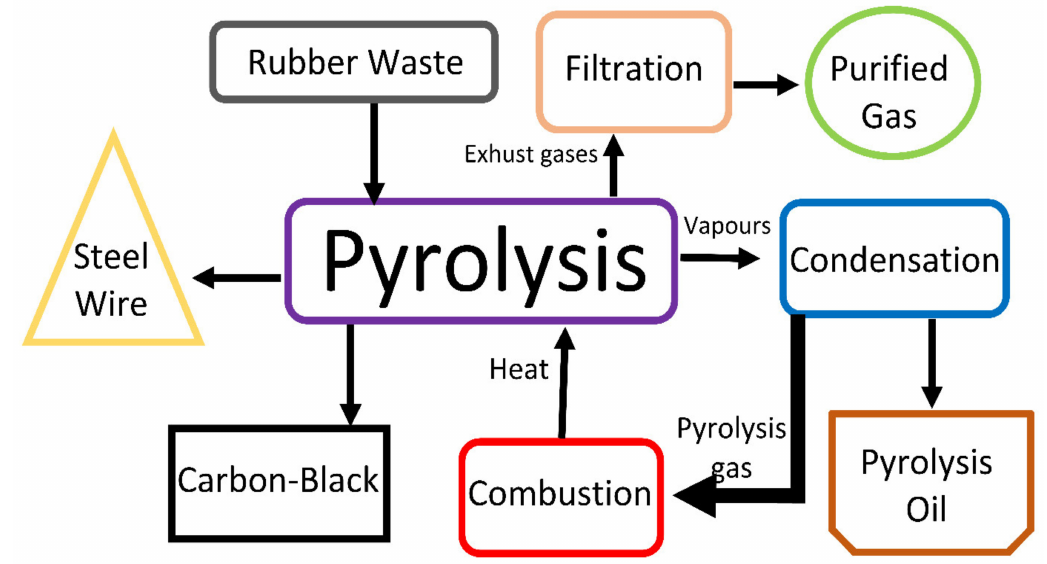
Figure 6. Pyrolysis PFD.